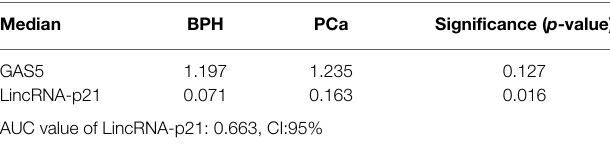
FIGURE 1 | Distribution of the exosomal GAS5 and lincRNA-p21 levels in the disease groups. The circles and asterisks represent the values (outliers) falling beyond the statistical distribution of the related variables (exosomal lincRNA-p21 or GAS5). TABLE 3 | Median values of exosomal lncRNAs and their statistical significances.